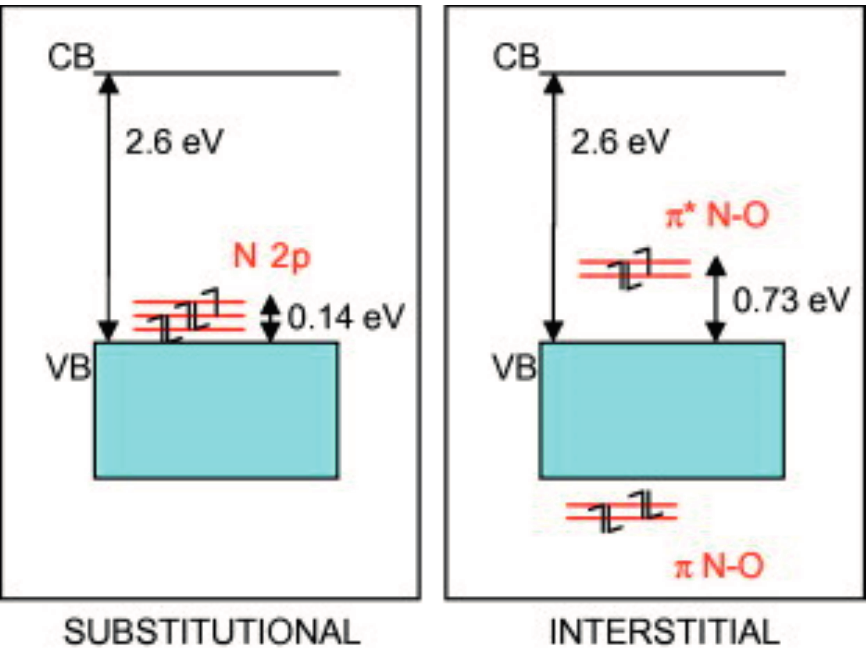
Figure 9. New energy states introduced into TiO 2 by substitutional and interstitial nitrogen. (reproduced from [126] with permission of